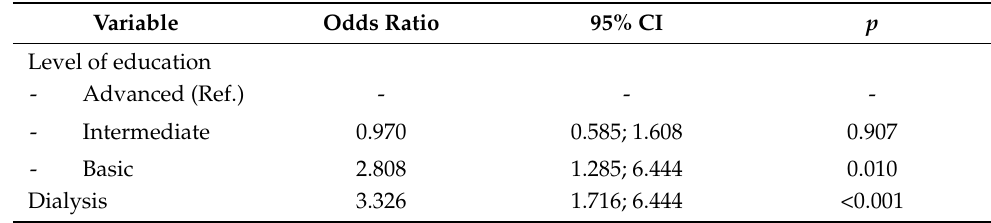
Table 2. Multivariable logistic regression for inadequate adherence to the Mediterranean diet in the whole population, including level of education and dialysis status.